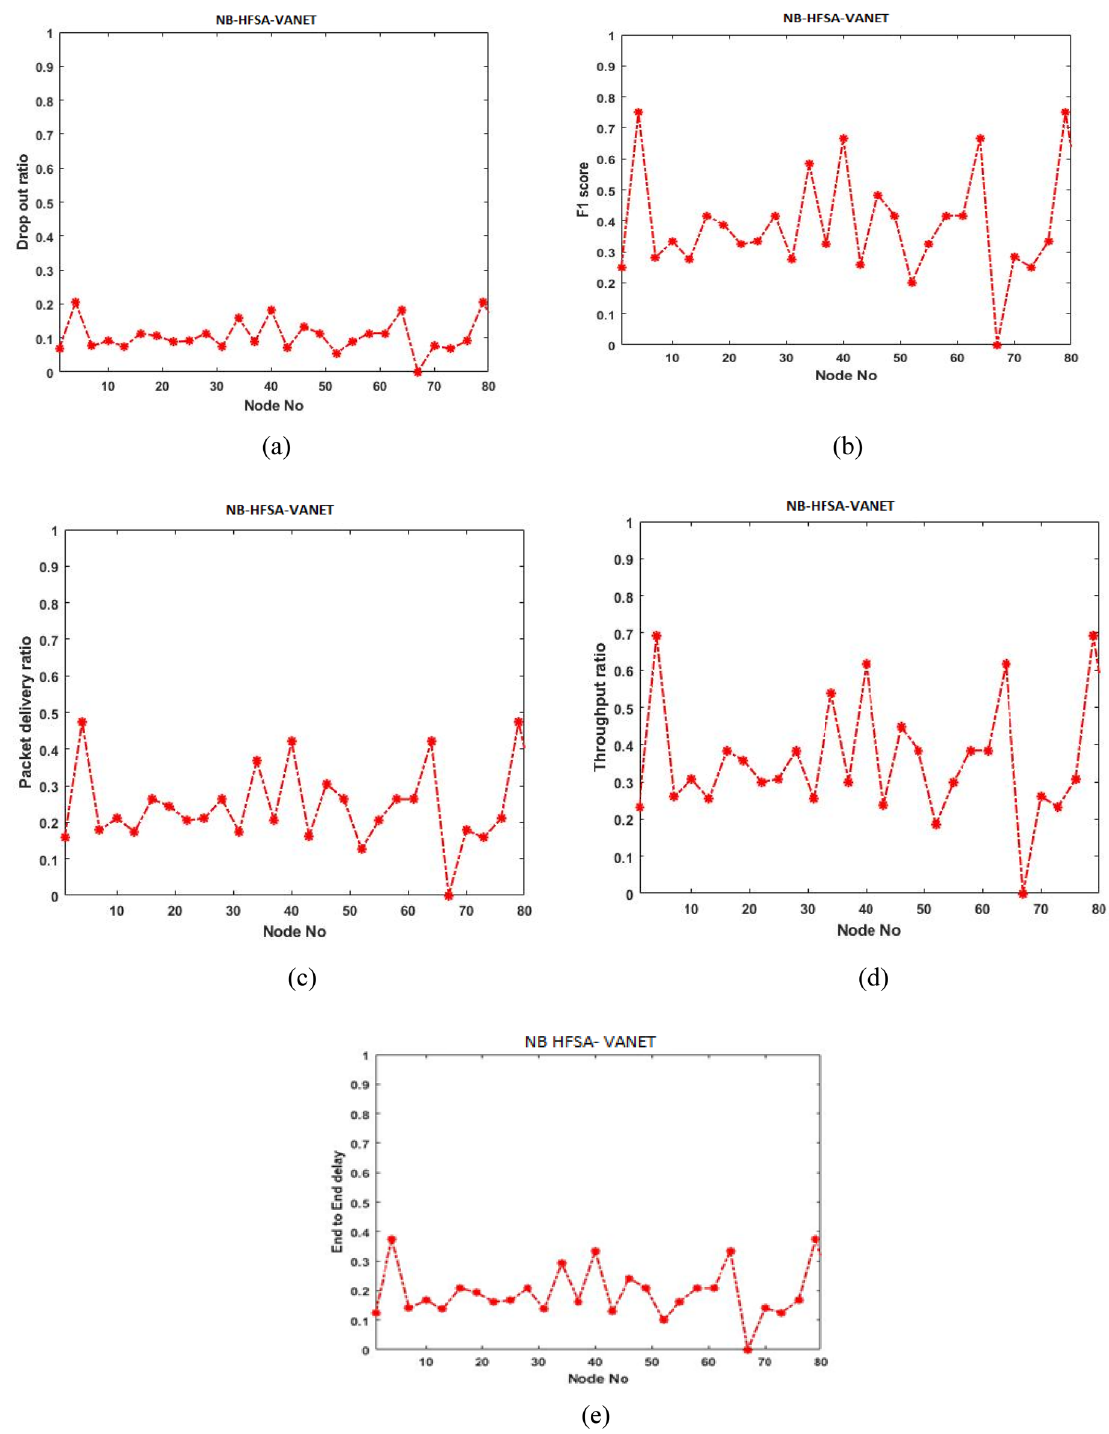
Figure 15. ( a ) Drop out ratio, ( b ) F1 score, ( c ) packet delivery ratio, ( d ) Through put ratio, ( e ) End to end